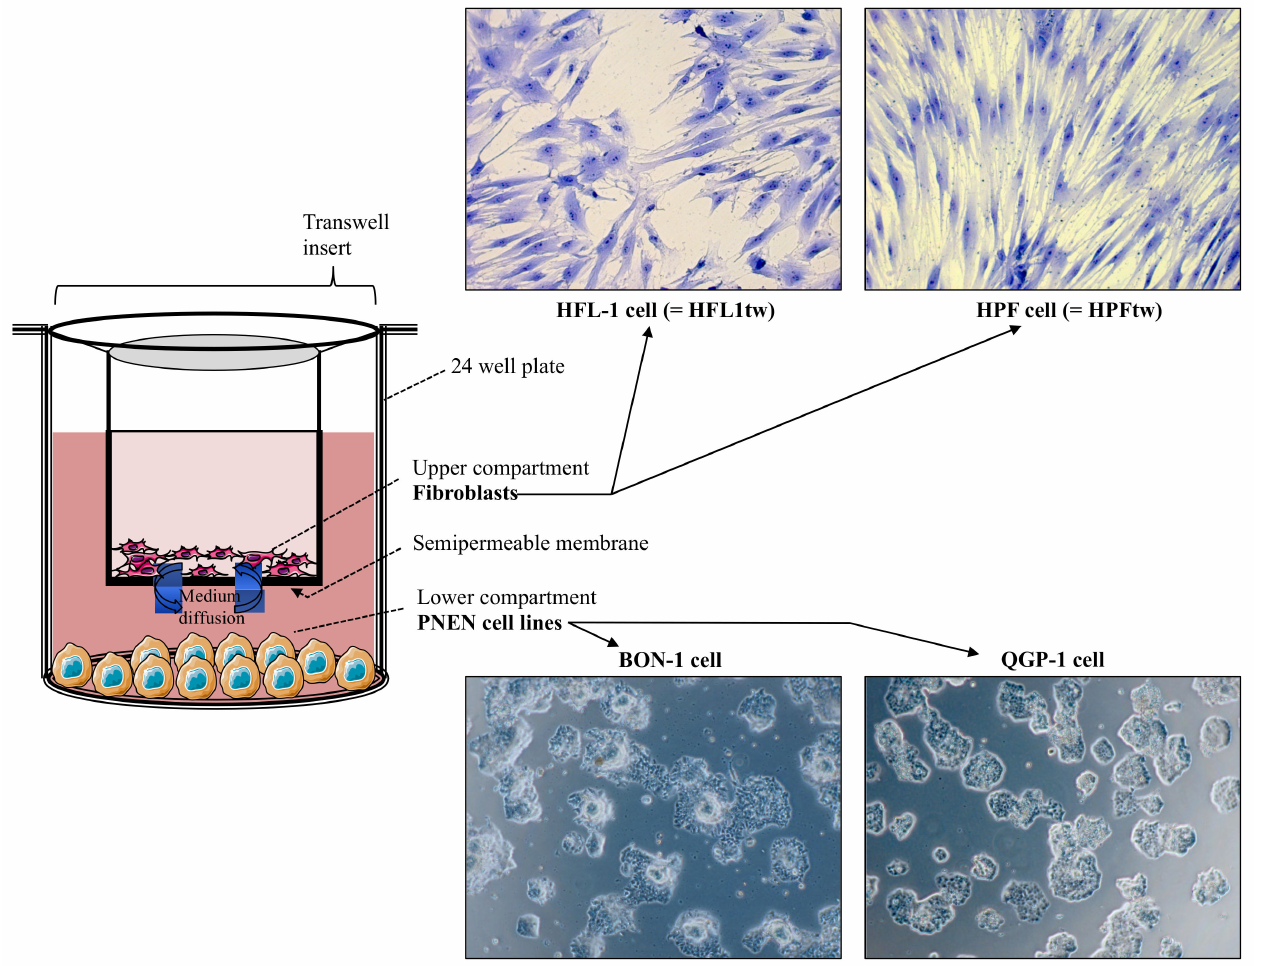
Figure 1. Schematic representation of the co-culture system (Boyden chamber). Human neuroen- docrine tumor cells BON-1 and QGP-1 were seeded in the lower compartment, while the HFL-1 and HPF cells were cultured in the upper compartment. The medium, and the produced factors, could diffuse through a semi-permeable